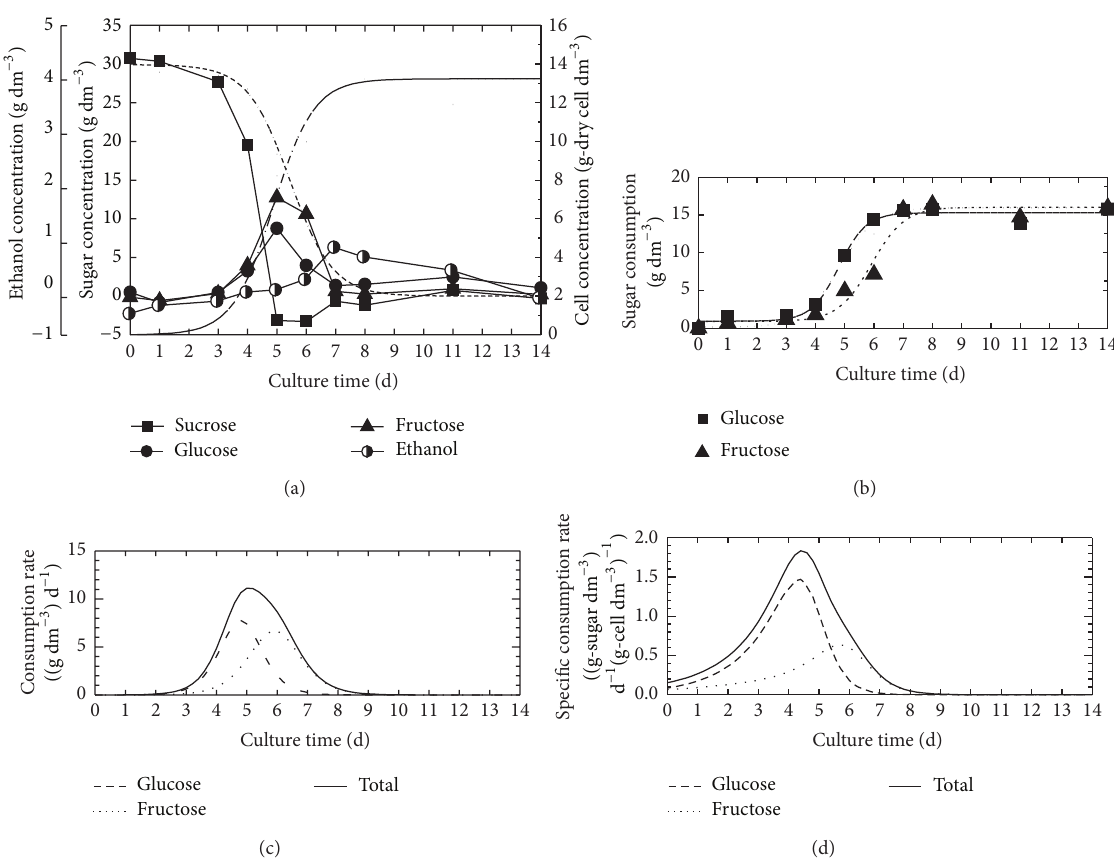
Figure 4: Time courses of sugar and ethanol concentrations (a), amount of the glucose and fructose consumptions (b), consumption rate (c), and specific consumption rate (d) of basal MS